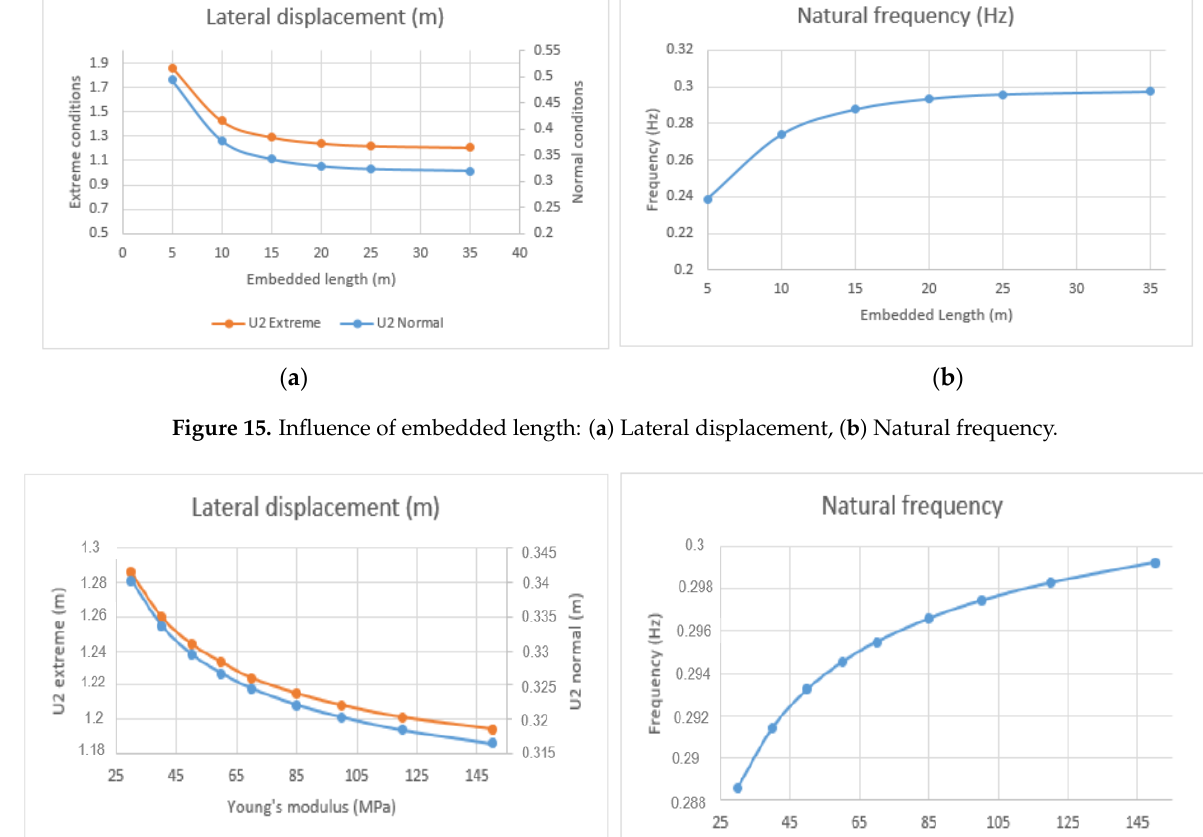
Figure 15. Influence of embedded length: ( a ) Lateral displacement, ( b ) Natural frequency.